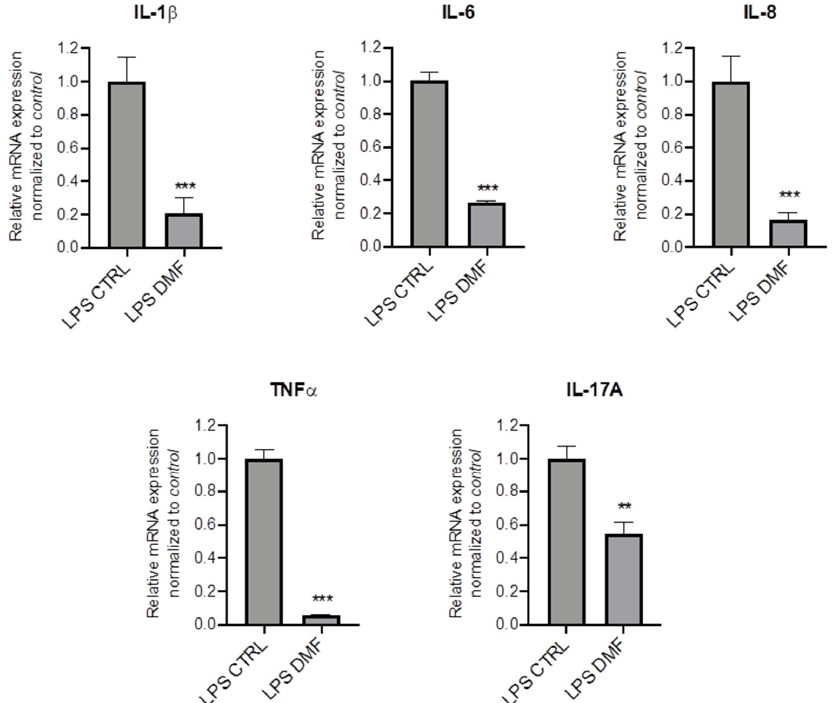
Figure 2. DMF reduces the expression of cytokines stimulated by LPS in CFBE cells. Cells were incubated with 10 µ g/mL of LPS for 1 h and afterwards with 0.1% DMSO (CTRL) or 50 µ M DMF. Total RNA was extracted and qRT-PCR was performed in order to quantify IL-1 β and TNF- α , IL-6, IL-8 and IL-17A mRNA normalized to untreated control. Results are shown as fold induction where CTRL is equal to 1. Data represent the mean ± SD ( n = 4). ** p < 0.01; *** p < 0.001.